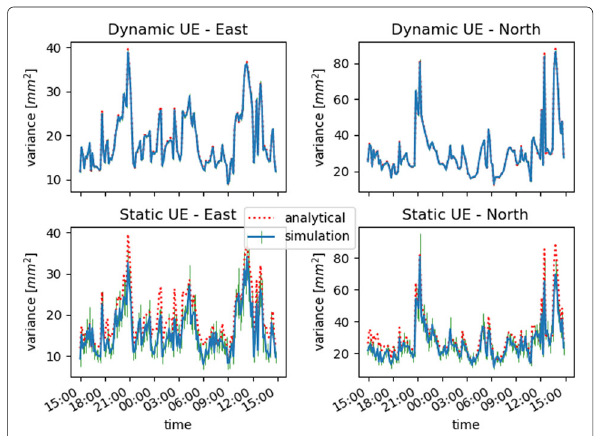
Fig. 13 Comparison between RTK localization error variance in Loc1 obtained from simulations, and computed with Eq.